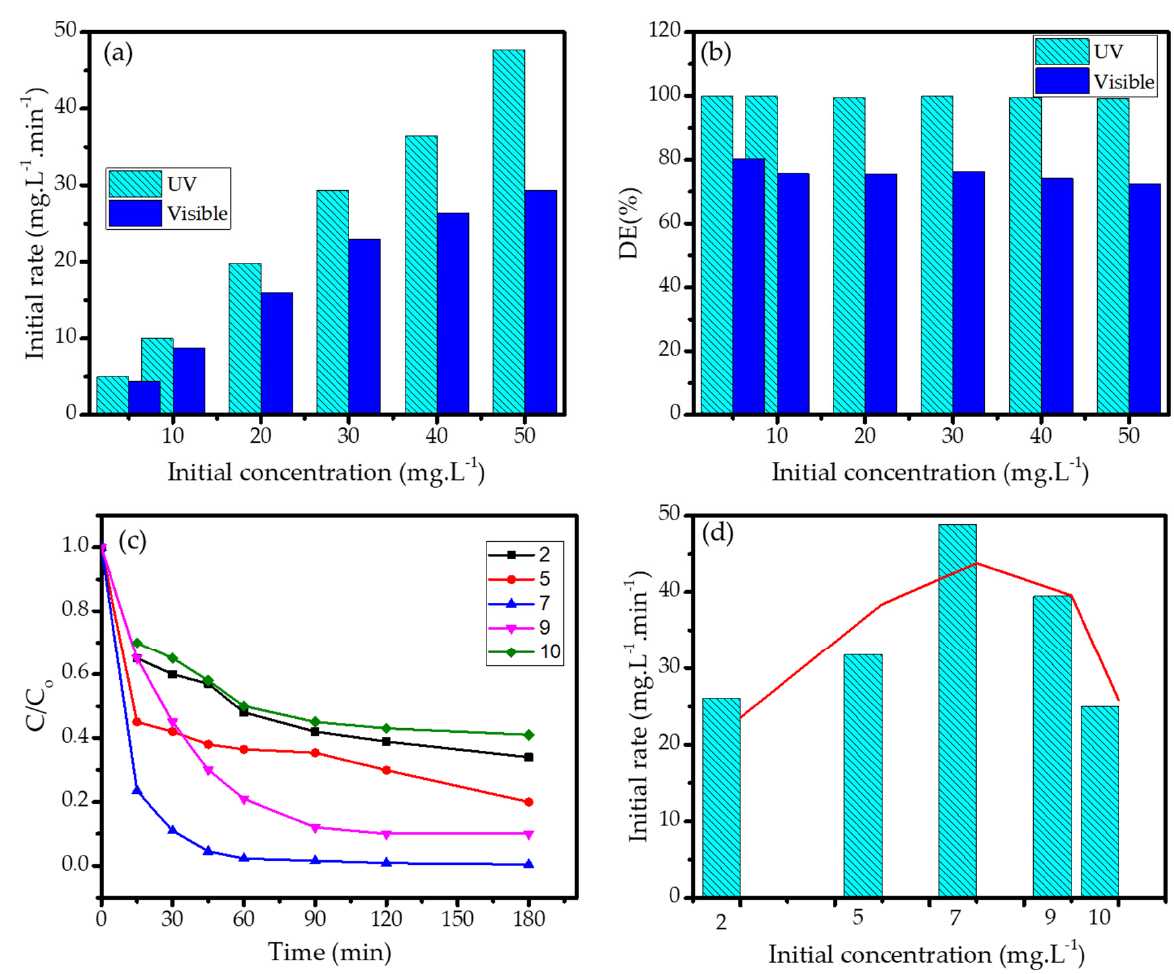
Figure 11. ( a ) Effect of initial concentration of MV on initial rate; ( b ) Effect of initial concentration of MV on DE; ( c ) Kinetics of MV photodegradation at varied pH; ( d ) DE at varied pH. Table 4. Comparison on photocatalytic activity of prepared ZnO/SiO 2 -PCH samples with other photocatalysts.